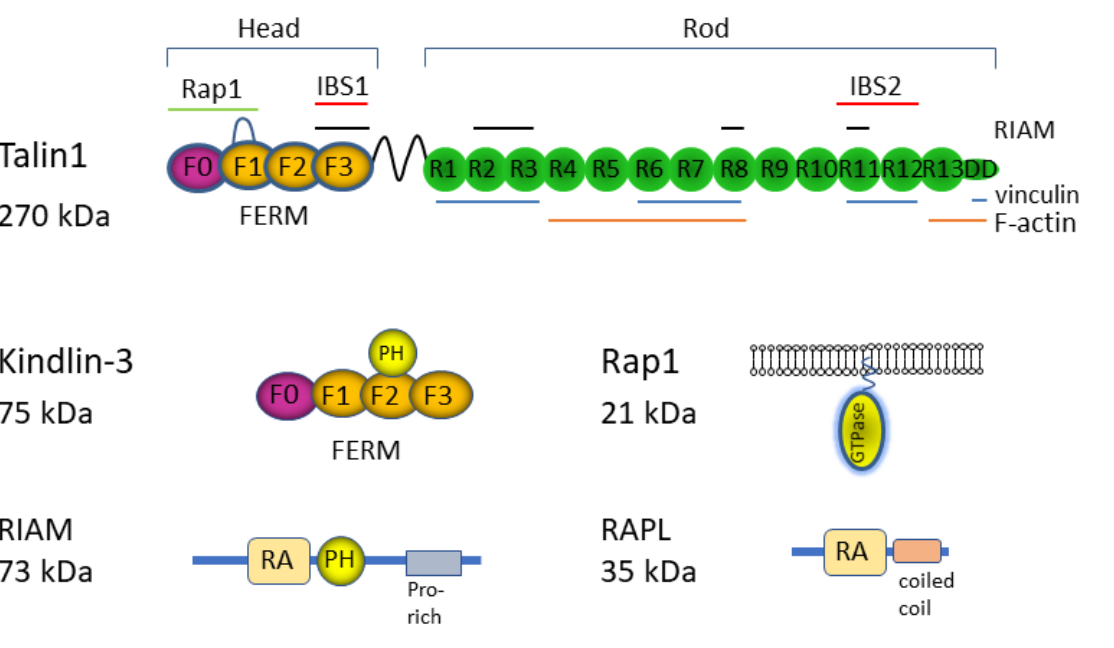
Figure 2. Integrin adaptors and Rap1 signaling molecules. Integrin adaptor proteins (talin1 and kindlin-3), Rap1, and Rap1 effector molecules are depicted with domain composition (see text). F0–F3 indicate subdomains of 4.1, ezrin, radixin, moesin (FERM) domain in Talin1 and Kindlin-3. R1–R13 indicate subdomains of ROD domain in Talin1. DD indicates dimerization domain. PH indicates pleckstrin homology domain. RA indicates Ras-associating